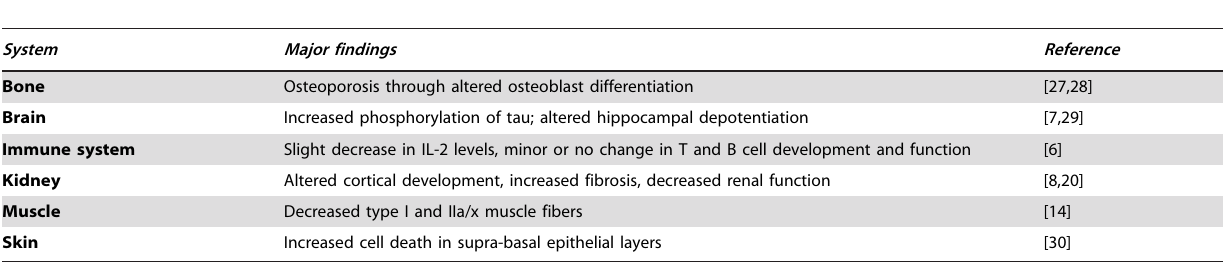
Table 3. Summary of previously published studies based on CnA a 2 / 2